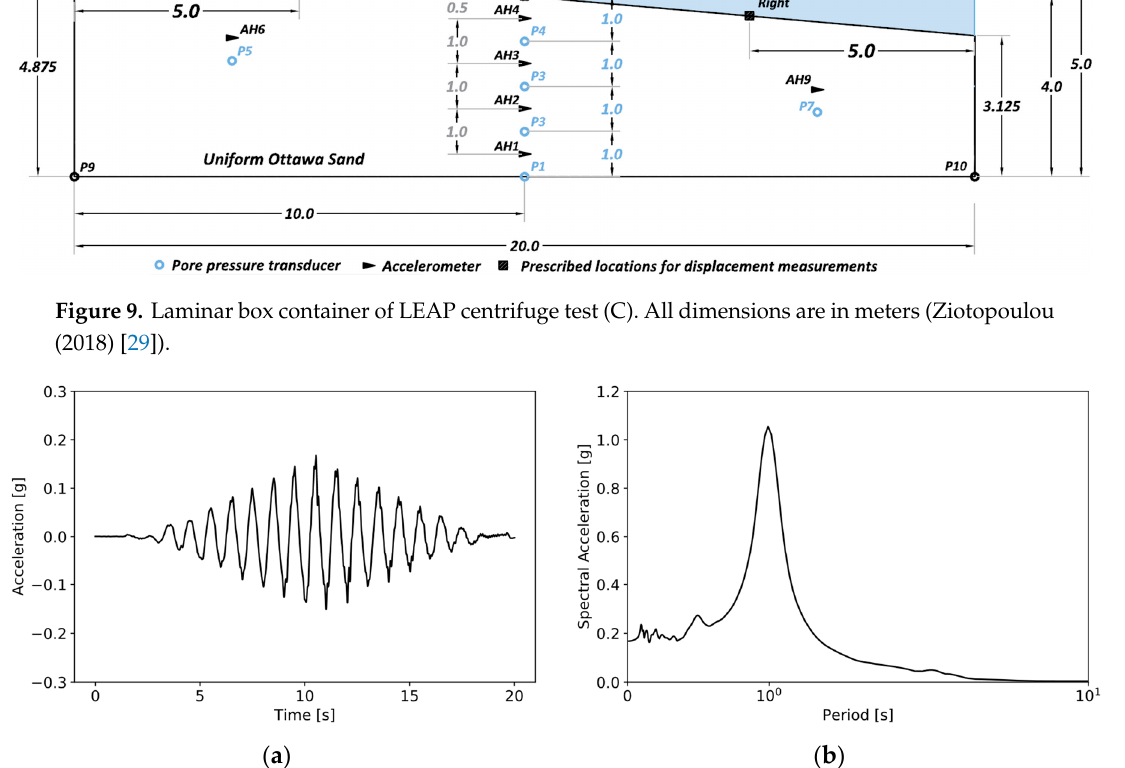
Figure 10. ( a ) Lateral acceleration at the base of the laminar box of LEAP conducted at Rensselaer